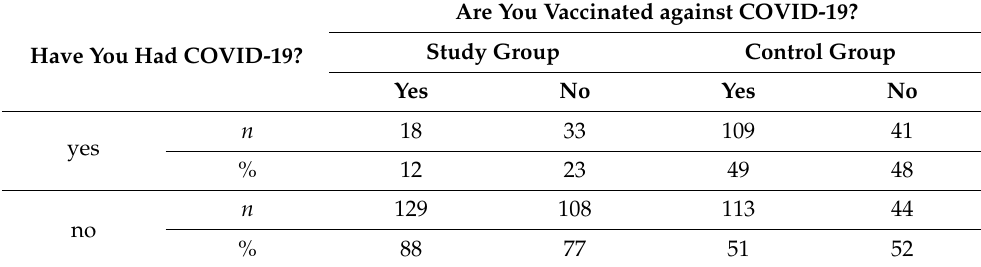
Table 3. Summary of COVID-19 rates and vaccine coverage.